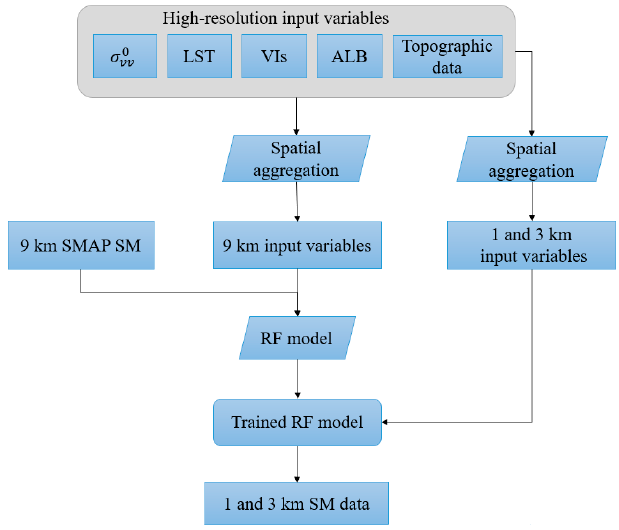
Figure 2. Schematic flow of downscaling coarse-resolution SM.